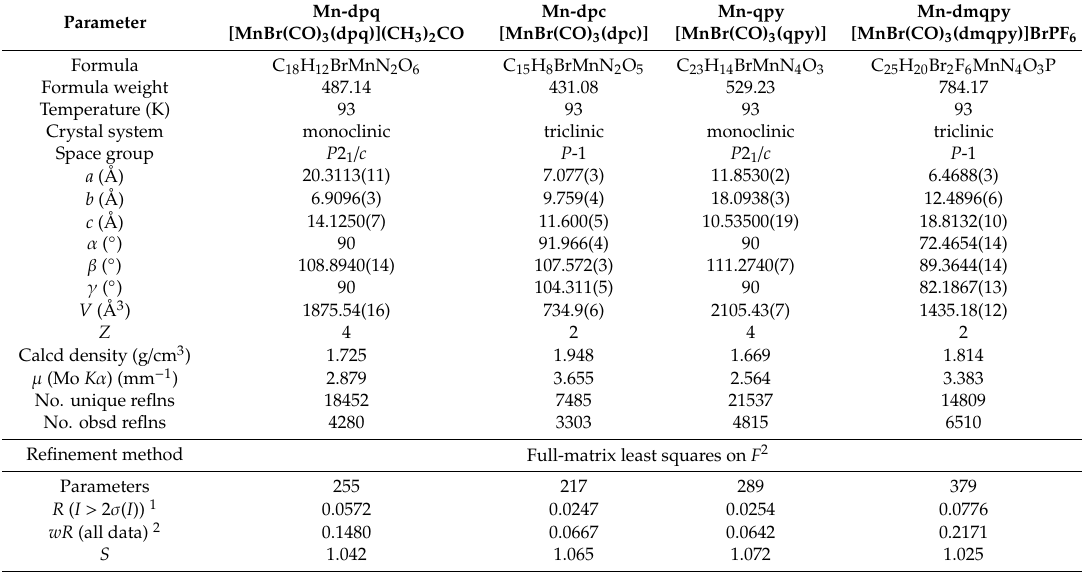
Table 4. Crystallographic data for the Mn(I)